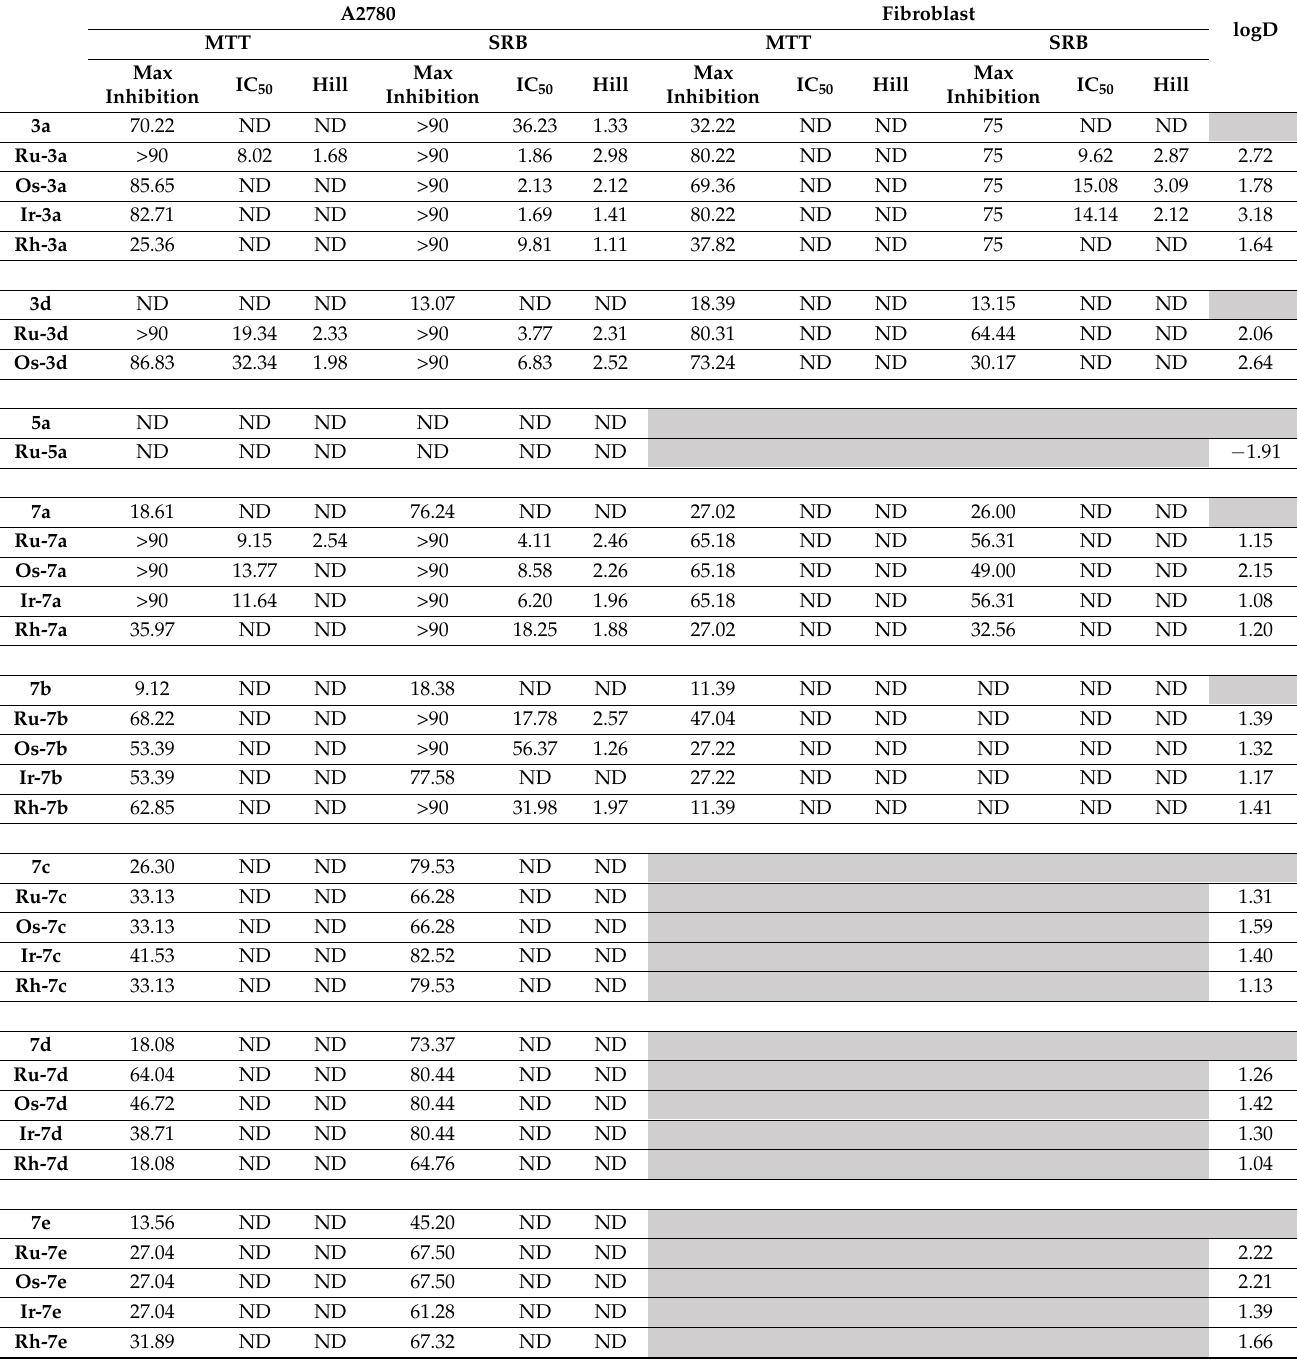
Table 6. Kinetic and logD values of the complexes assessed in the present